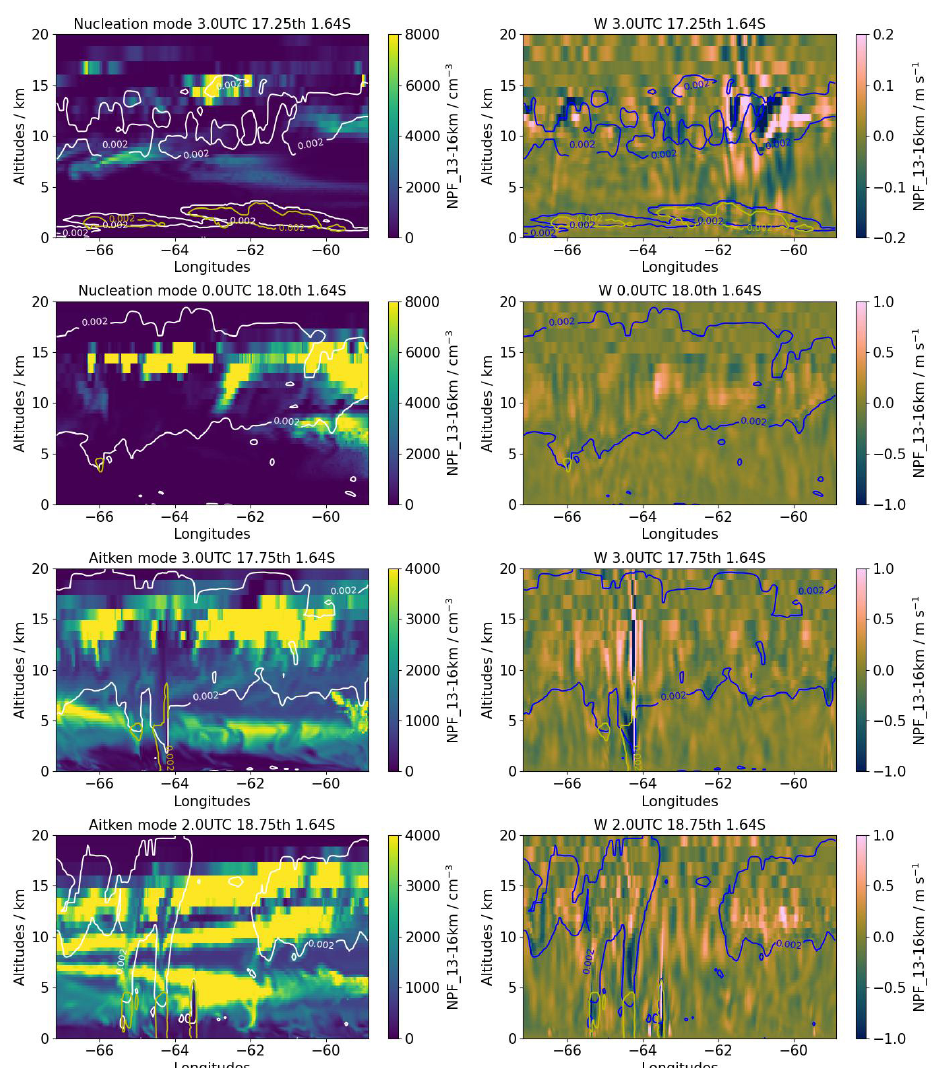
Figure 11. West to east vertical slices at 1.64S of nucleation mode (first two rows), Aitken mode (lower two rows) number concentrations and the vertical velocity from the NPF_13-16km regional simulation at various times (see panel titles) in order to highlight vertical transport. Easterly winds were dominant. White and blue contours highlight clouds (liquid plus frozen water content = 0.002gkg − 1 ), and yellow contours denote rain mass mixing ratios of 0.002gkg − 1 . Videos of the nucleation, Aitken and accumulation mode aerosol slices can be found in the